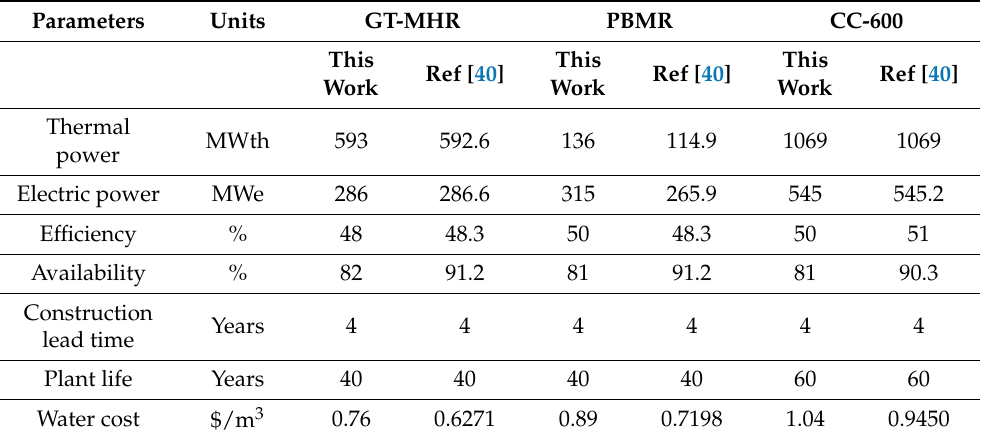
Table 9. Comparisons of nuclear with other power